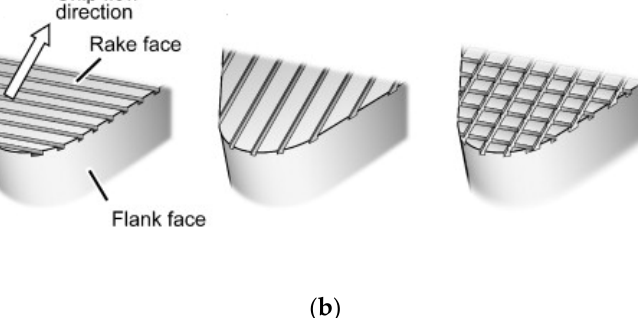
Figure 5. ( a ): Schematic diagram indicating the differences between the mode of deformation during conventional machining and surface defect machining (SDM) observed through an FEA (Finite Element Analysis) simulation of hard steel and MD (Molecular Dinamics) simulation of silicon carbide, respectively; ( b ) effect of providing nanogrooves on the tool [78]. ( a ) Surface defect machining. ( b ) Providing nanogrooves on the tool.